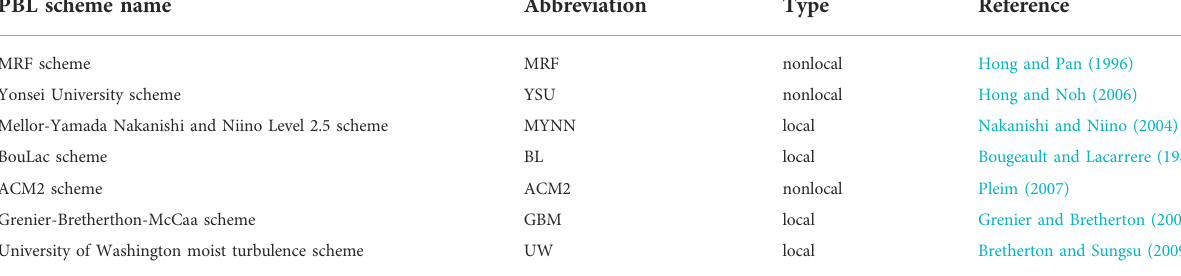
TABLE 1 Summary of the PBL schemes examined in the